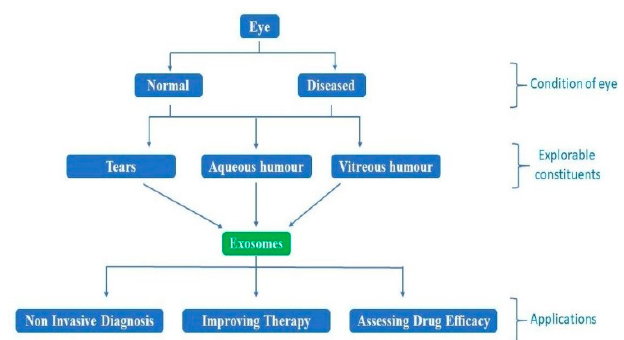
Figure 1. The schematic drawing of how the exosomes may be studied for various applications in the pathophysiology of the retinoblastoma and other eye cancers.